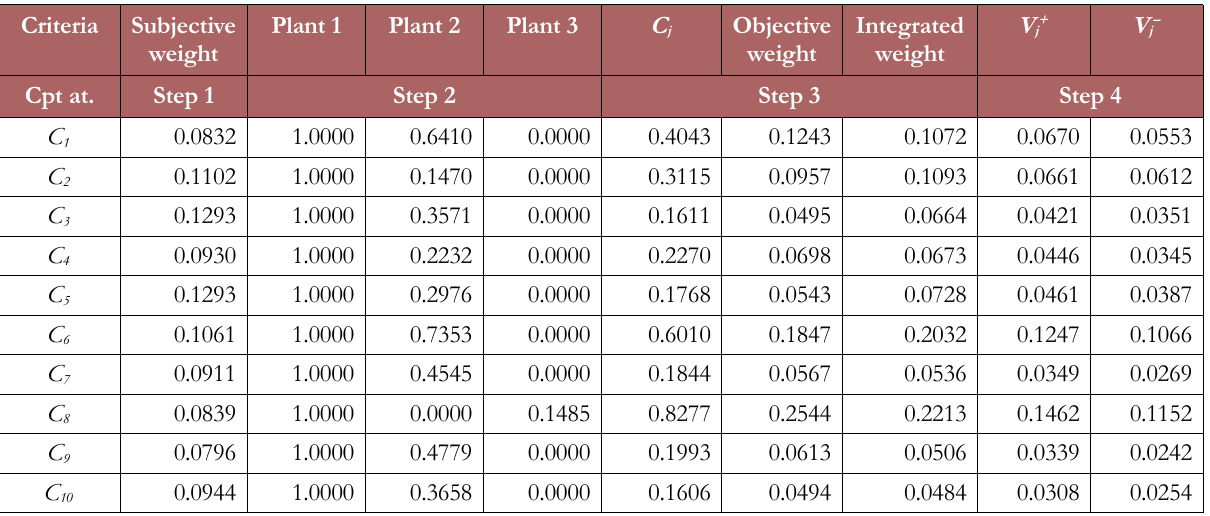
Table 3. Computation of rough BWM-CRITIC-TOPSIS (AM)